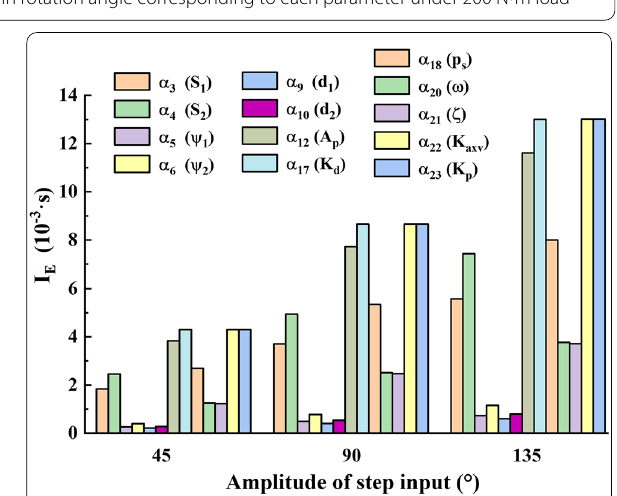
Figure 16 Histogram of sensitivity index under different step inputs and 100 N m ·